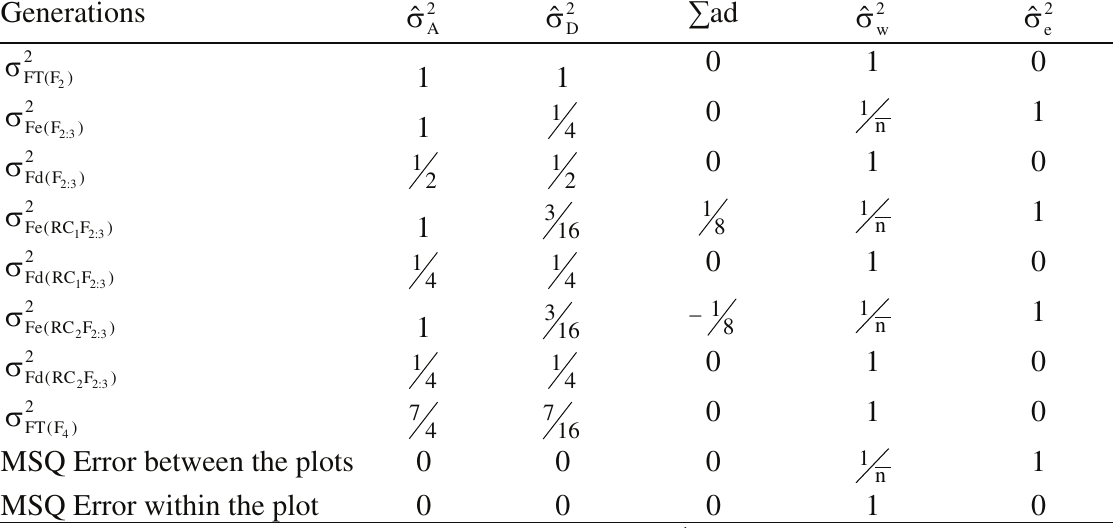
Table S2 – Genetic and environmental components associated to phenotypic variances of inbred lines and segregating generations, without considering the influence of epistatic effects on trait